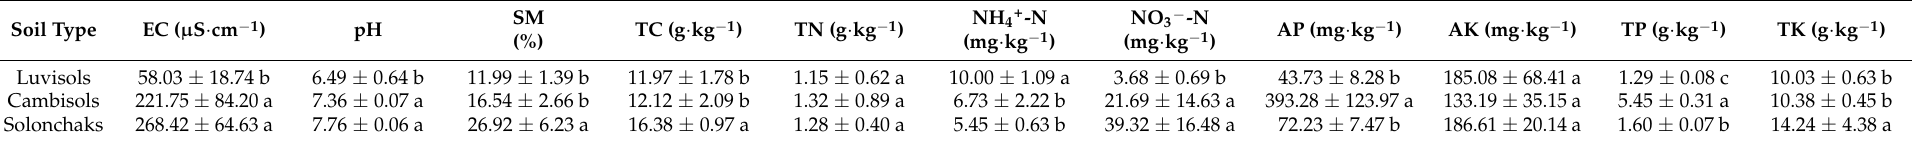
Table 2. Analysis of rhizosphere soil environmental factors in pecan